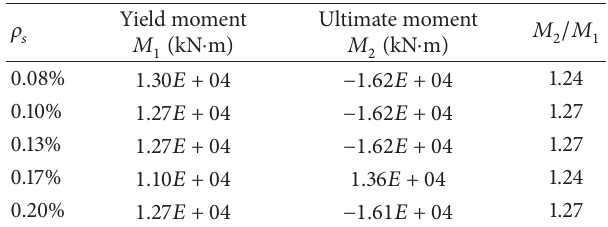
Table 4: Calculation results of PRC bridge piers with different longitudinal stirrups